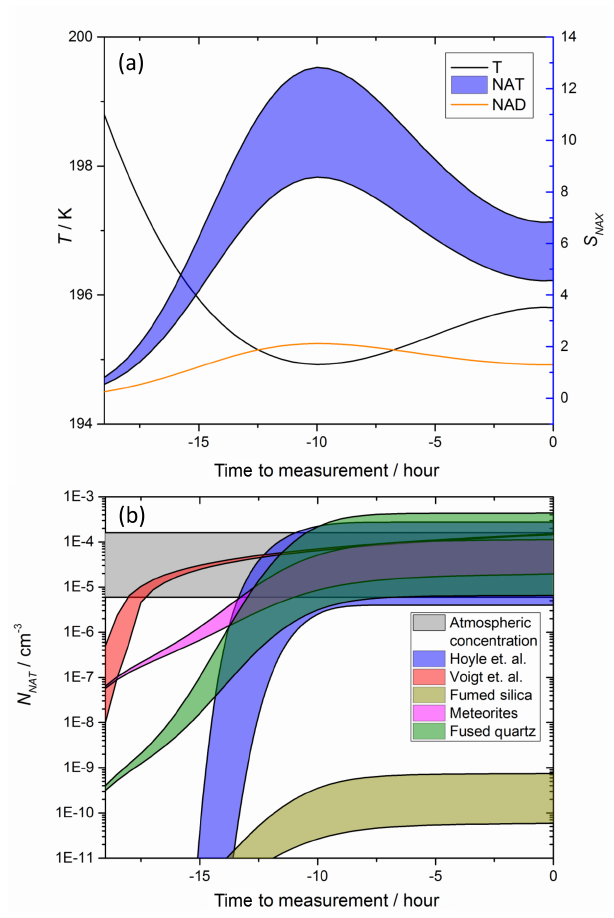
Figure 6. NAT particle production using a temperature trajectory based on stratospheric observations. Temperature profile (a) was taken from back trajectories which ended in cloud with observed N NAT shown in the grey shaded area (b) (Voigt et al., 2005). S NAX shown in (a) were calculated at 70hPa assuming 5ppmv H 2 O, 0.1ppbv H 2 SO 4 and 10 (minimum of ranges) to 15ppbv (maximum of ranges) HNO 3 . No other processes (e.g. growth or sedimenta- tion of particles) are taken into account. Panel (b) shows predicted N NAT based on our n s parameterizations and estimated surface ar- eas of meteoric material as well as two literature parameterizations (Hoyle et al., 2013; Voigt et al.,